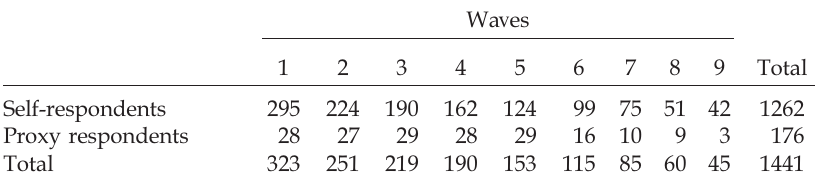
Table 1. Number of inter v iews with the community-dwelling participants across the nine wa v es of SWILSOO